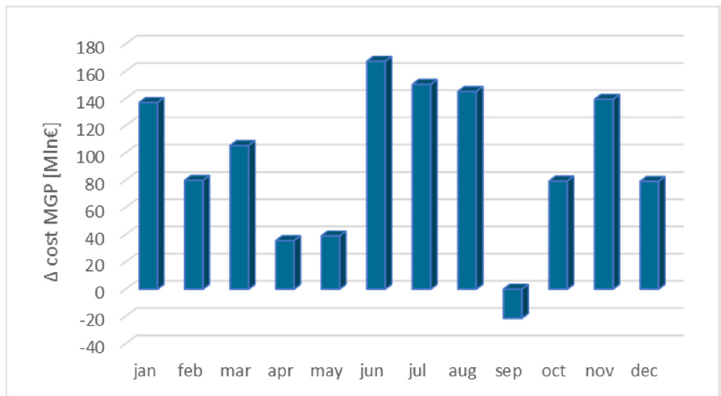
Figure 13. Monthly MGP cost increase when the RR auction is in